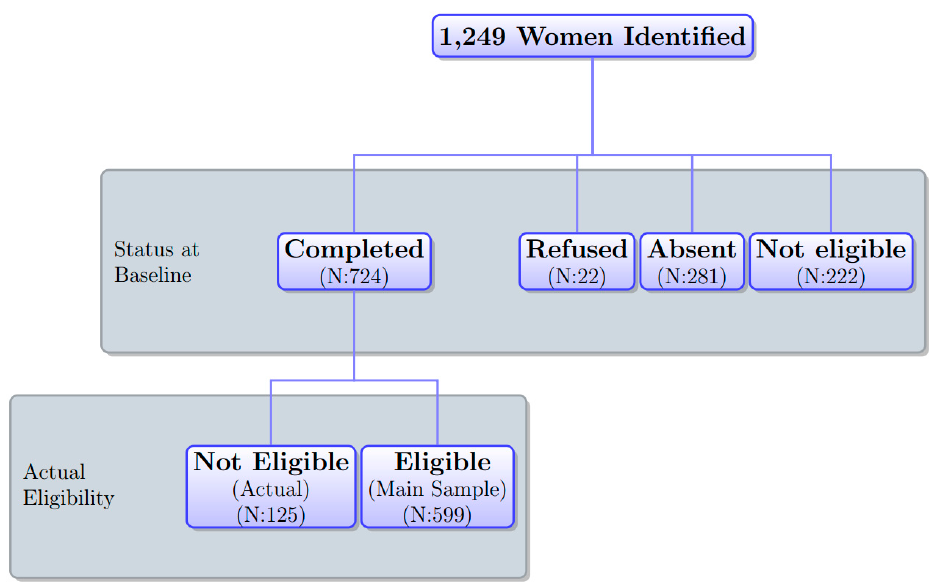
Figure 1. Sample. Notes: N is the number of observations.